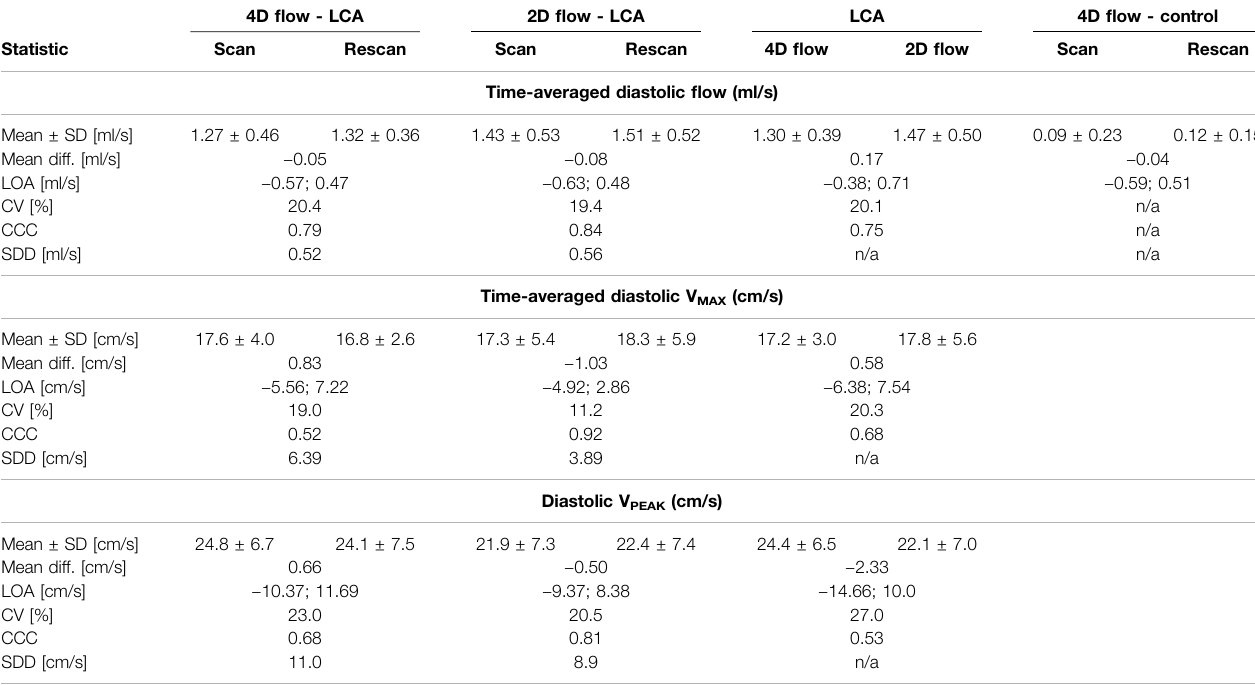
TABLE 1 | Statistical results regarding scan-rescan repeatability and agreement between 4D fl ow MRI and 2D fl ow